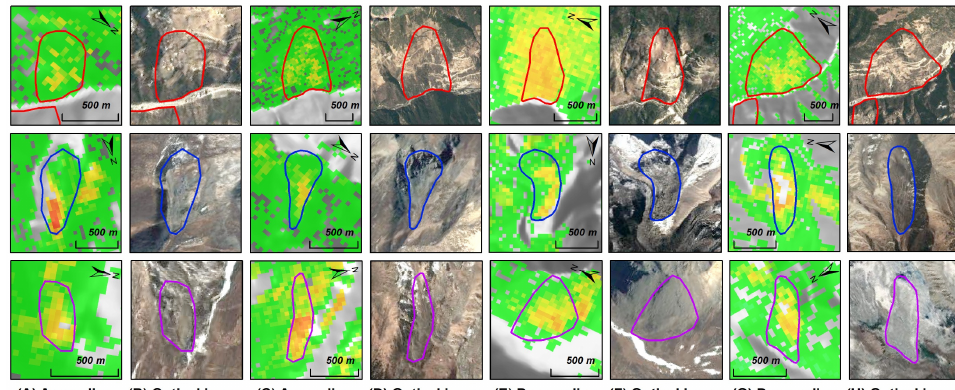
Figure 5. Typical landslide deformation maps and optical images. The optical images (about 2-meter resolution) were obtained from the Google Earth platform. (The legend is the same as Figure 4.)